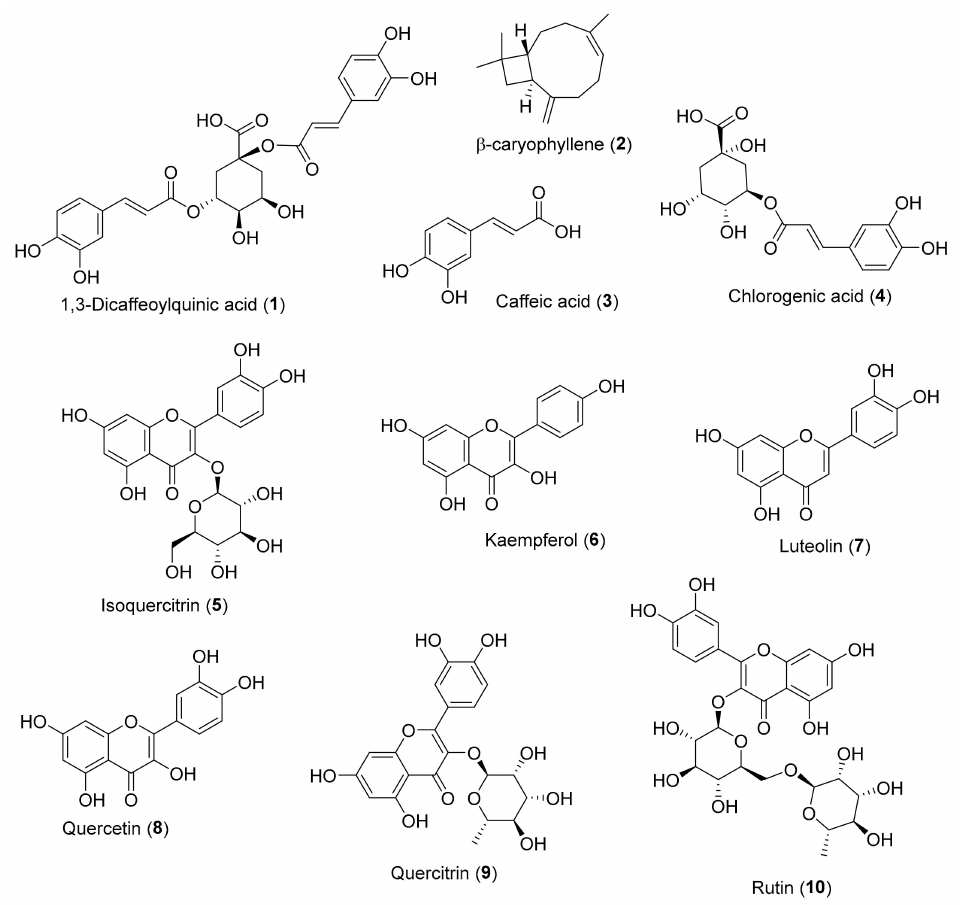
Figure 1. Chemical structure of Inula secondary metabolites ( 1 – 10 ) with DPPH and / or ABTS antioxidant